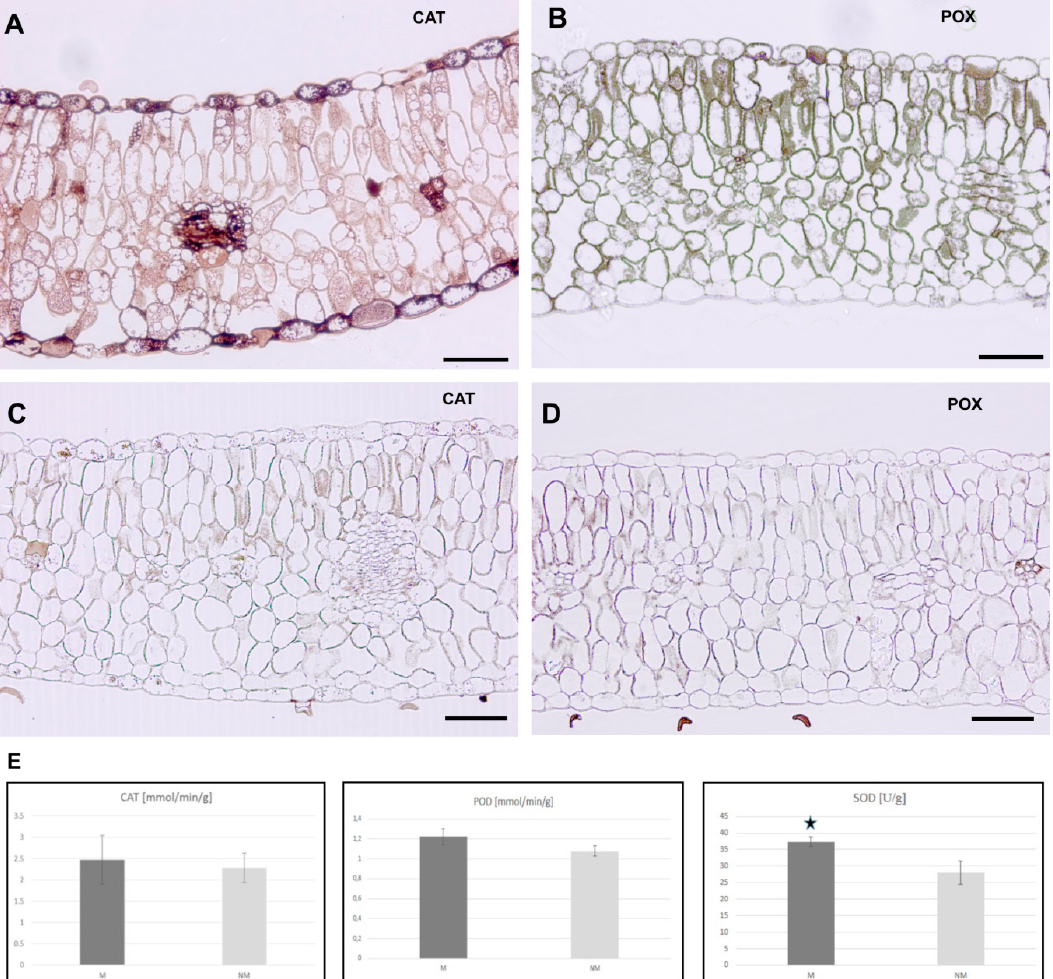
Figure 6. Antioxidant activity in leaves of A. vulneraria specimens. ( A – D ) Localization of catalase (CAT) and peroxidase (POX) activity in metallicolous (M) ( A , B ) and non-metallicolous (NM) ( C , D ) leaves. Dark brown coloration indicated enzyme presence. Bars = 50 µm. ( E ) The level of antioxidant enzymes’ activity in Anthyllis leaves. Asterisk indicates the significant difference at p < 0.05 according to one-way ANOVA and post-hoc Tukey’s test.